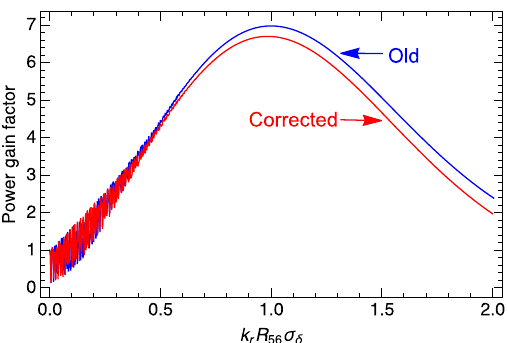
FIG. 1. 1D power gain factor with relative energy spread σ δ ¼ 0 . 1 ρ . Red line shows the gain with the corrected formula, while the blue line used the old